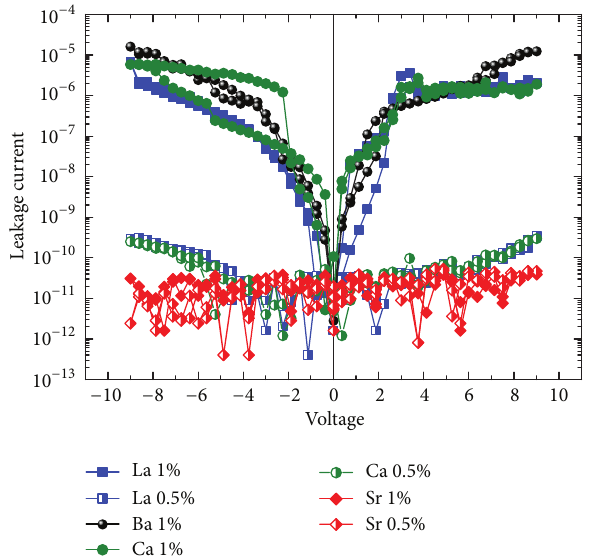
Ba FeO 3 films. x x